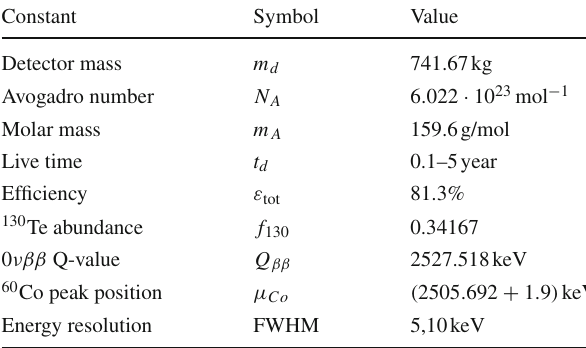
Table 3 Constants used in H 0 and H